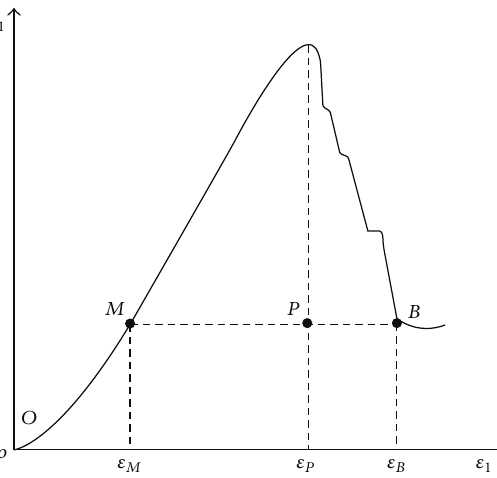
Figure 10: Typical complete stress-strain curve of brittle rocks.